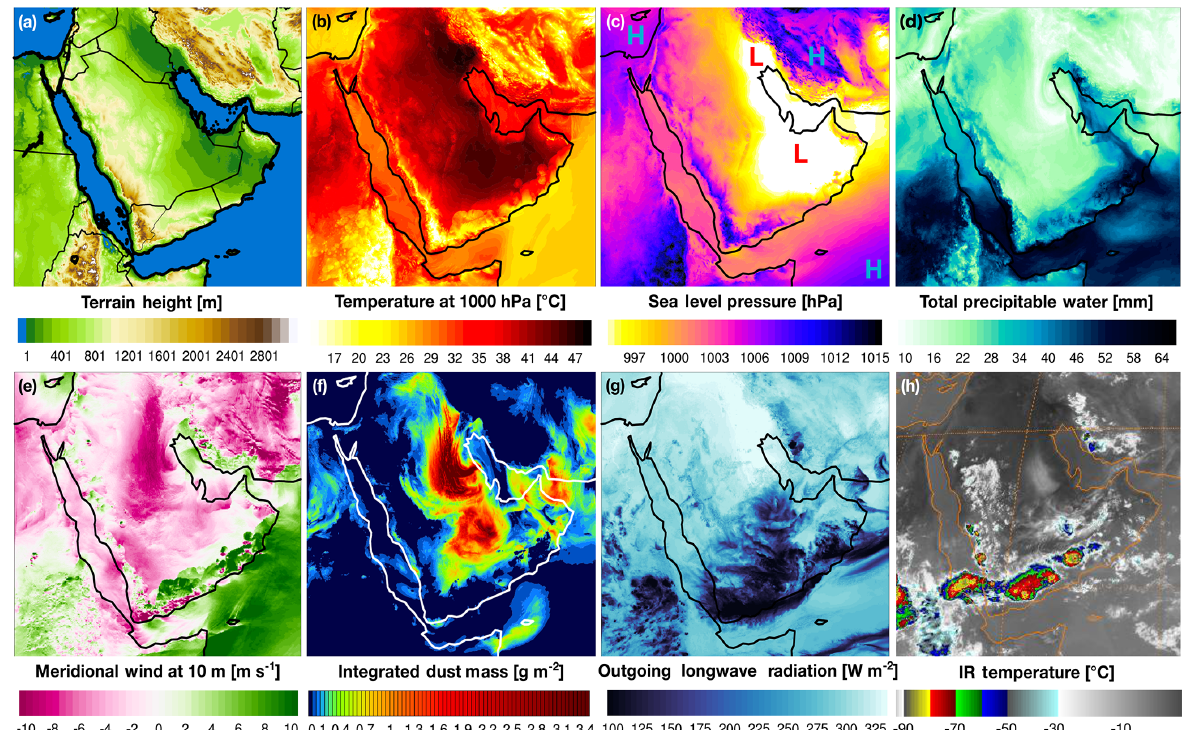
Figure 1. Case study topography and meteorology for 3 August 2016 at 15:00UTC: (a) terrain height and national boundaries, (b) 1000hPa temperature, (c) sea level pressure, (d) total precipitable water, (e) meridional winds at 10ma.g.l., (f) vertically integrated dust mass, (g) out- going longwave radiation, and (h) IR temperature. Panel (h) is observed from Meteosat-7, whereas panels (a) – (g) are snapshots from the 3km WRF-Chem